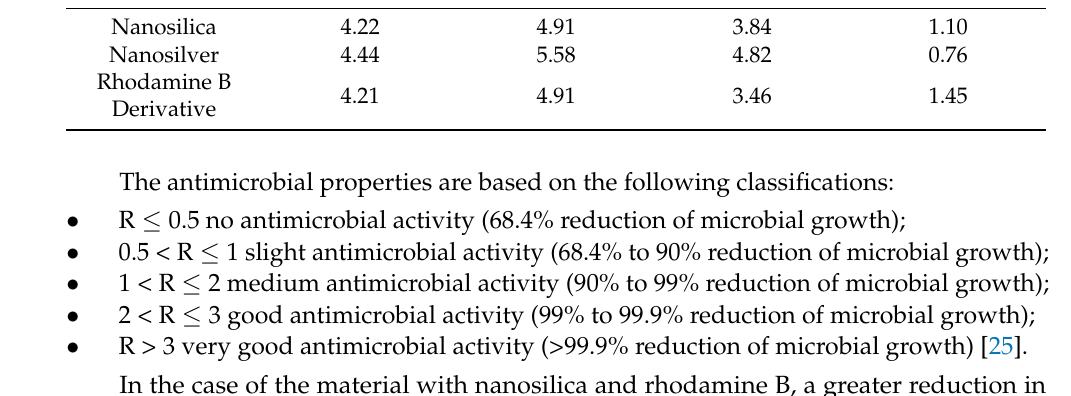
Table 1. Evaluation of the antibacterial activity of the modified polyester surface.